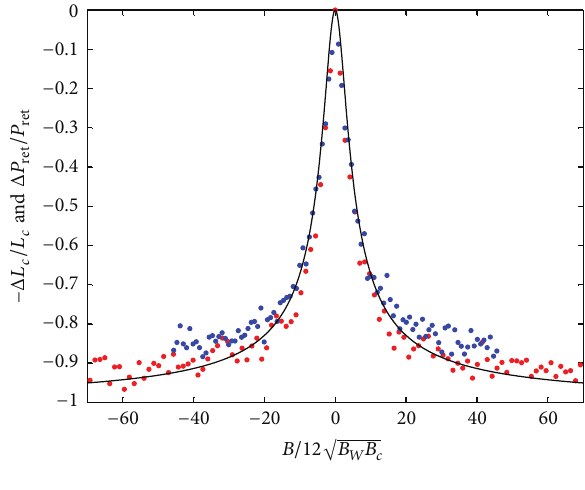
Figure 3: We compare the analytical expression (solid line) for /𝑃 Δ𝑃 from (17), relevant to the quasi-1D situation, with the ret ret numerically obtained relative change in the localization length using the parameter 𝐵 𝑒 = 100𝐵 𝑐 . The different dot colors (blue, red) represent different widths (80 ×𝑎 , 120 ×𝑎 ) of the simulated graphene device, where 𝑎 is the lattice